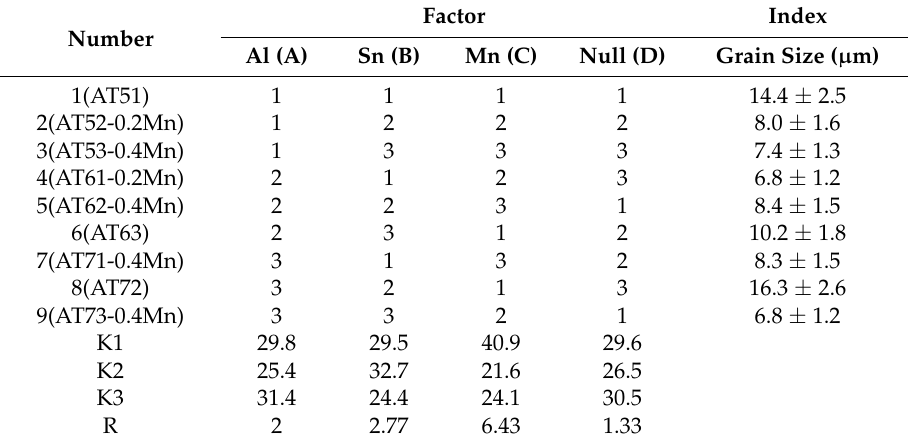
Table 1. Orthogonal test parameters and results analysis table under the grain size index. Factor Number